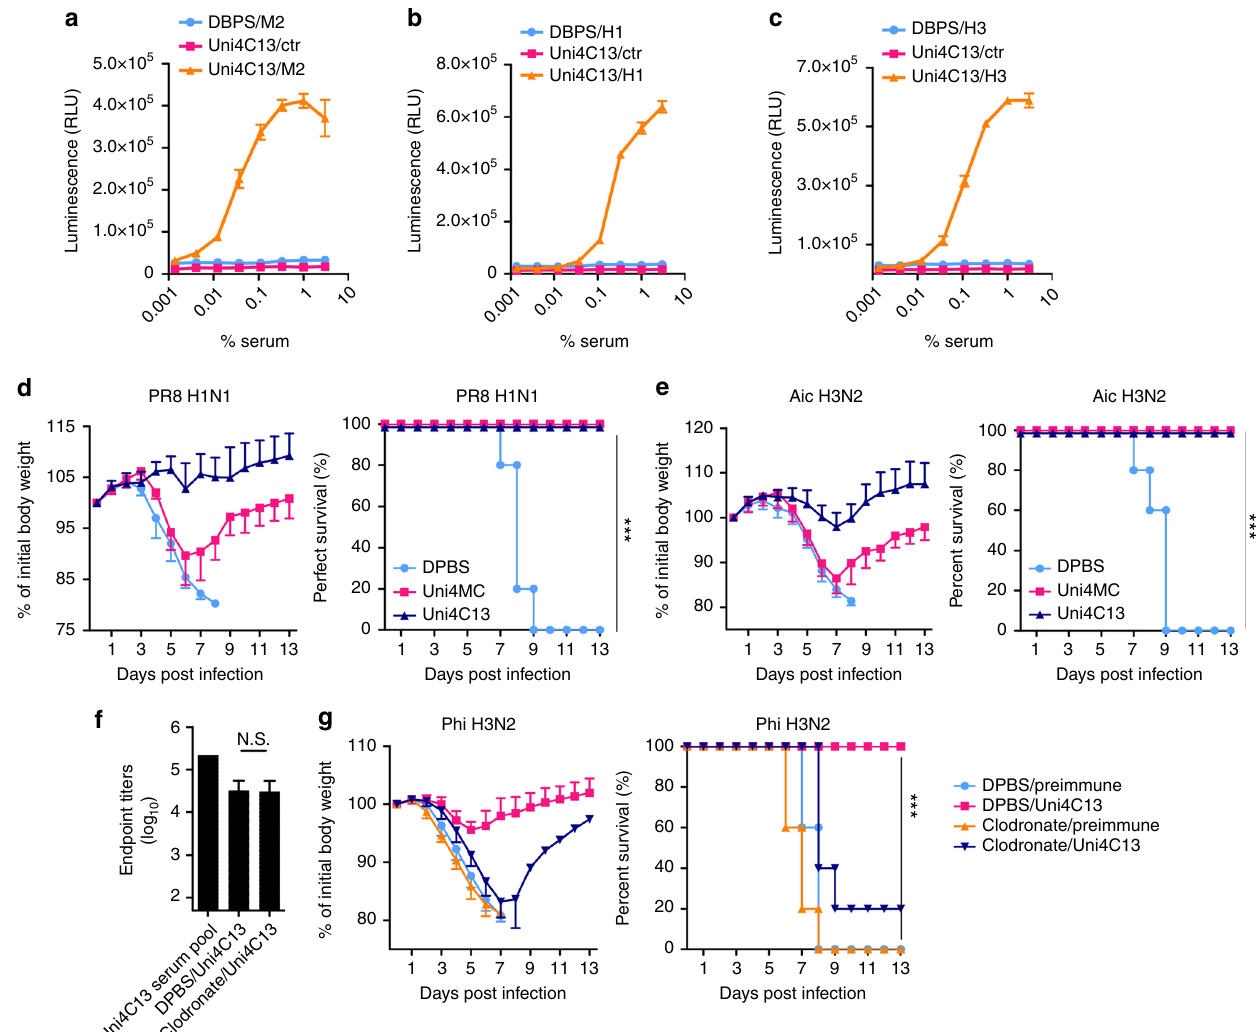
Fig. 6 Correlates of immune Protection. a – c ADCC surrogate assay with pooled pre-challenge sera from each immunization group and transiently transfected HEK293T target cells expressing M2 ( a ), H1( b ) or H3 ( c ). The non-transfected HEK293T cells were used as negative control. ( n = 3) RLU: Relative light units. Data are presented as mean ± SD. The experiments were repeated twice with similar results. d – g Protection by passive transfer of immune sera. Immune sera from mice immunized with Uni4MC, Uni4C13 or mock, respectively, were pooled and transferred to naïve recipient mice 24 h before challenge with 3 × mLD 50 PR8 H1N1 ( d ) or Aic H3N2 ( e ). f Left bar represents the anti-M2e IgG endpoint titer in Uni4C13 serum pool that was used for intraperitoneal passive transfer. Other two bars show the anti-M2e IgG endpoint titers in PBS loaded or clodronate-loaded liposomes treated recipient mice. g Morbidity and mortality of BALB/c mice receiving pre-immune or Uni4C13 serum, depleted or not depleted of alveolar macrophages, then were challenged with 3 × mLD 50 Phi H3N2. Body weight loss and survival rate were monitored for 14 days. Statistical signi fi cance analysis of survival rates was performed by Kaplan-Meier analysis for d – g . *** p < 0.005. Data are presented as mean ± SD ( n = 5) and statistical signi fi cance was analyzed by t -test